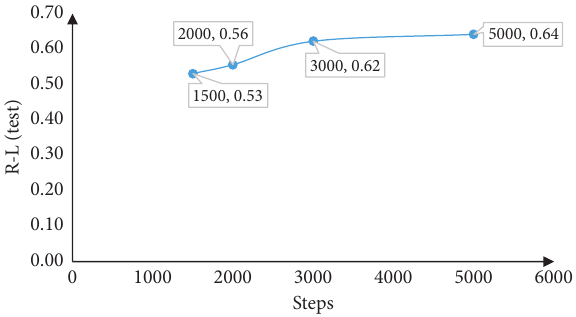
Figure 8: The comparison of different steps.